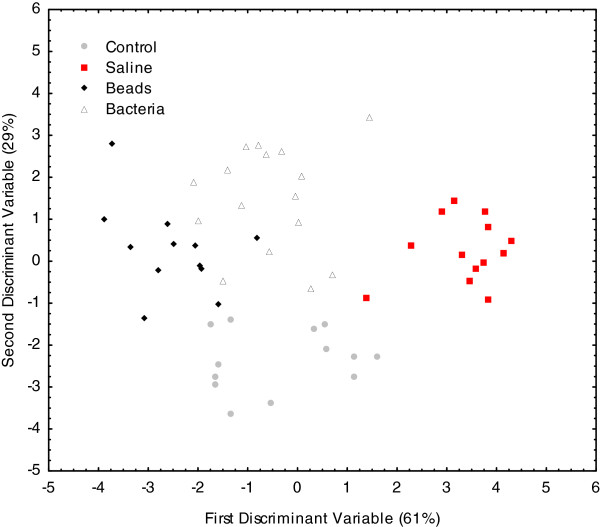
Effects of immunostimulation on the absolute quantities of cuticular hydrocarbons. Discriminant analysis was used to determine if there were significant differences in the cuticular hydrocarbon profiles of control, saline-, bead- and bacteria-injected individuals, based on absolute quantity of each compound. There were significant differences across all treatments F(51, 102)=4.32; p<0.0001.